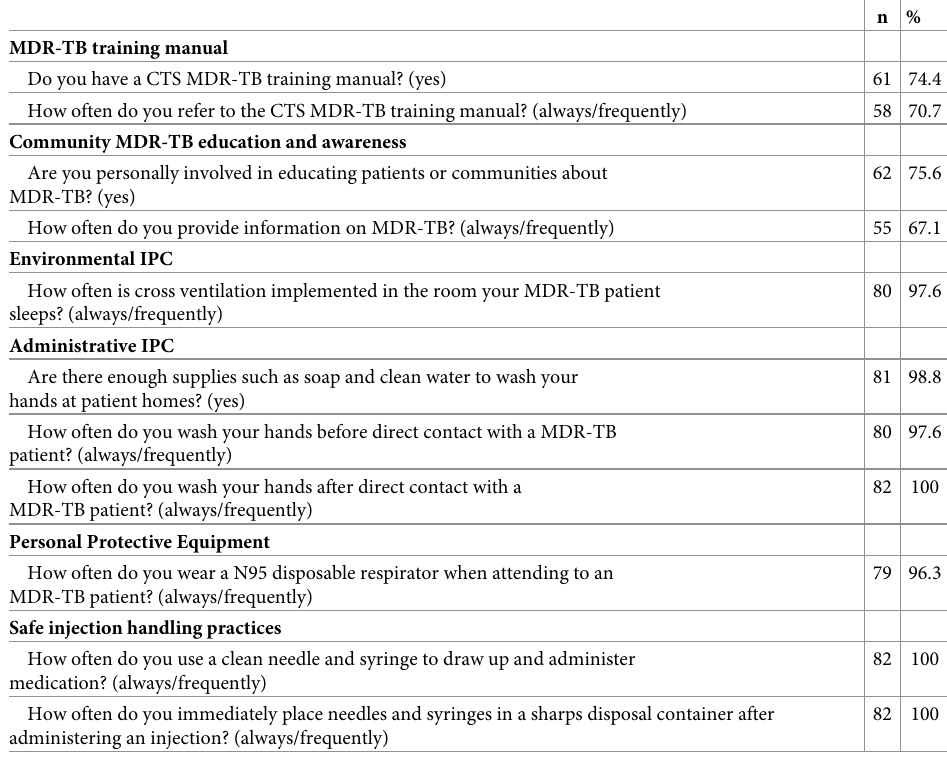
Table 4. Self-reported CTSs’ community based MDR-TB